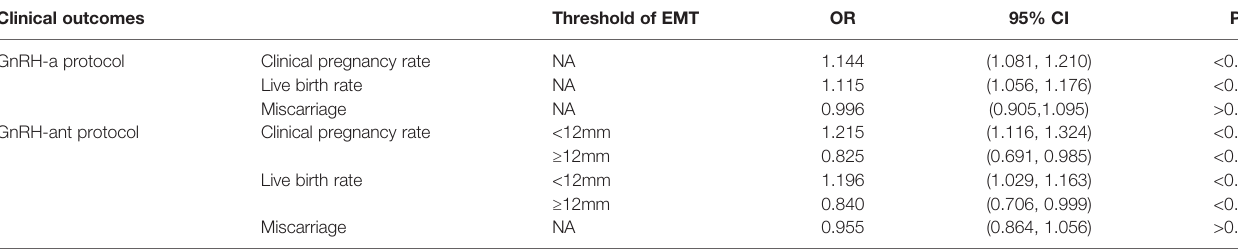
TABLE 7 | Threshold effect analysis of endometrial thickness and clinical outcomes. Clinical